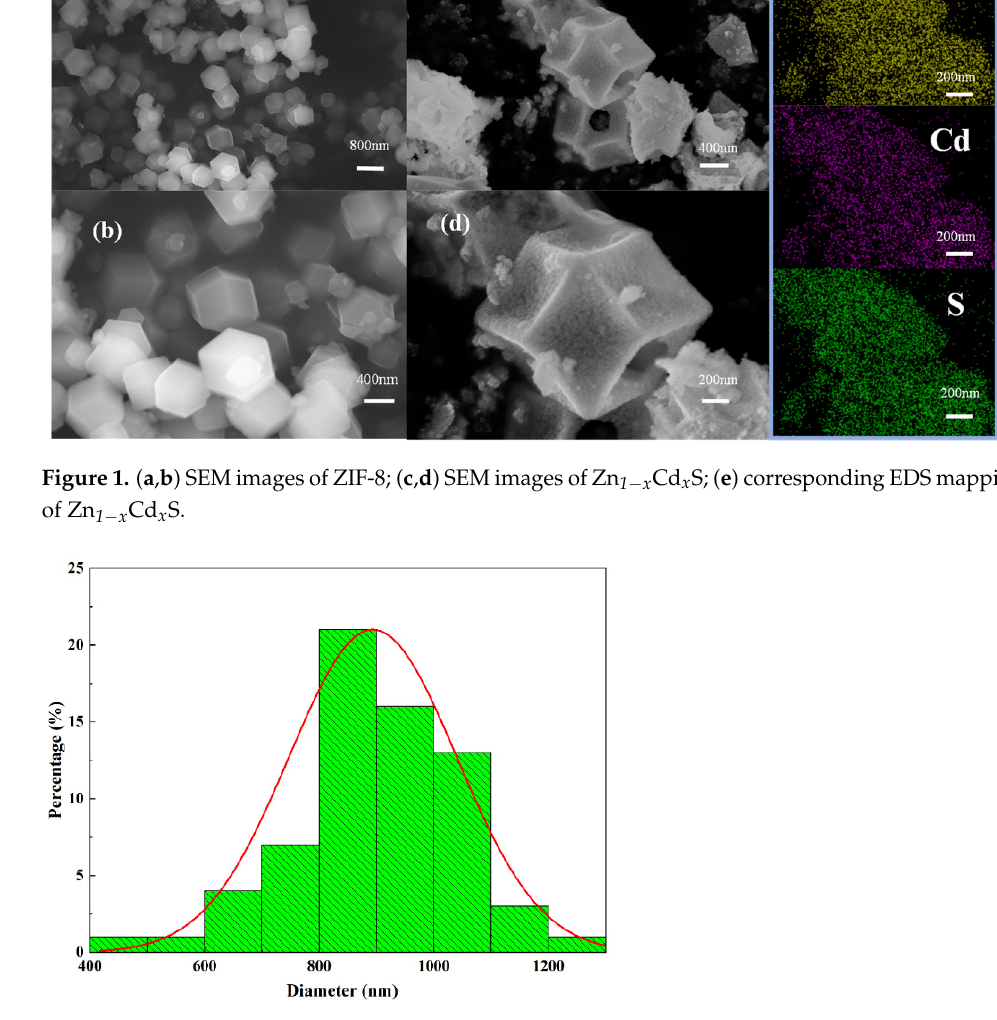
Figure 2. Particle size distribution of prepared Zn 1-x Cd x S catalyst.